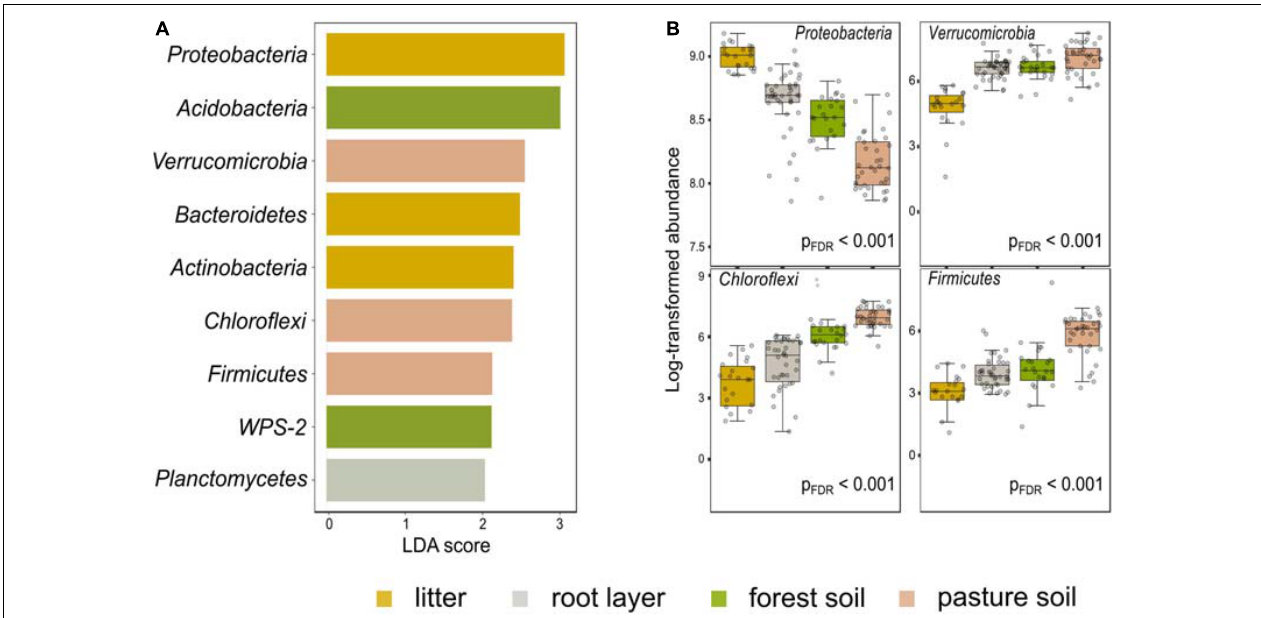
FIGURE 4 | Differential abundance among the most relevant taxa in the forest floor and pasture bulk soil in the Western Brazilian Amazonia. LEfSe multivariate analysis to significant differential abundances [false discovery rate adjusted p -value (p FDR ) < 0.001] with LDA > 2.0; (A) features selected between the compartments of the forest floor and the pasture bulk soil; (B) first four features based on p FDR < 0.001, without the application of the